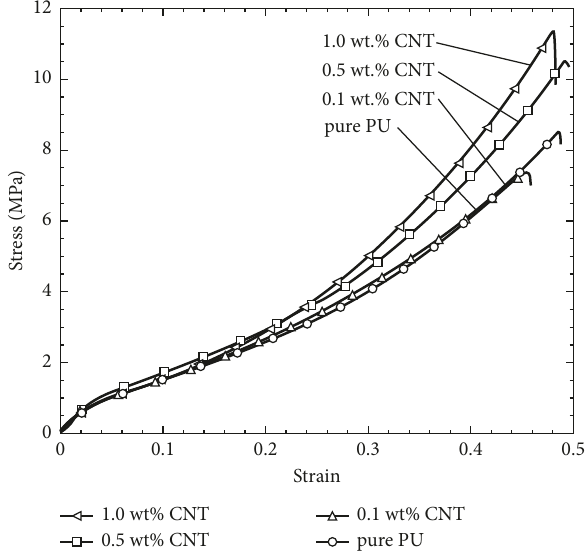
Figure 7: Tensile tests of four PU specimens with different contents of carbon nanotubes (strain rate, 2.3 mens, 48 days; thickness,